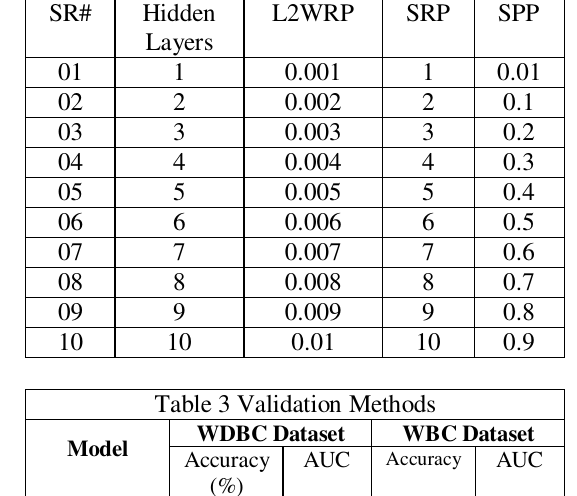
Table 3 Validation